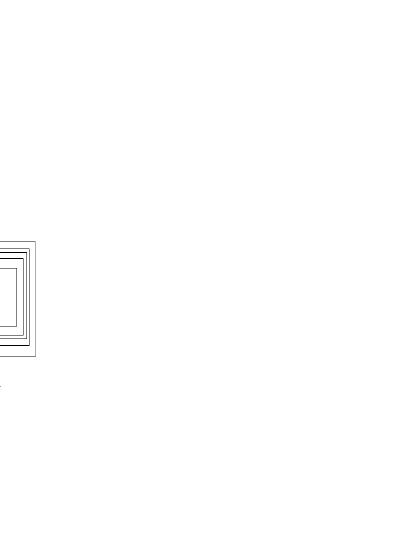
Fig 4. Fabricated initial (top) and modified (bottom) planar square loops.